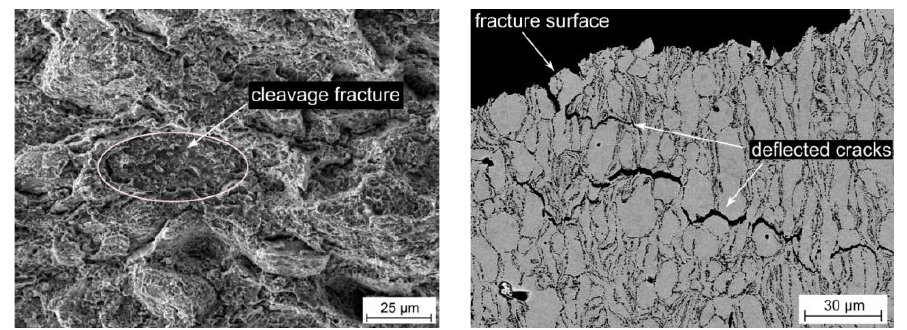
Fig. 4. SEM image: fracture surface of a M3 sample with areas of cleavage fracture (left) and perpendicular to the fracture surface (right).